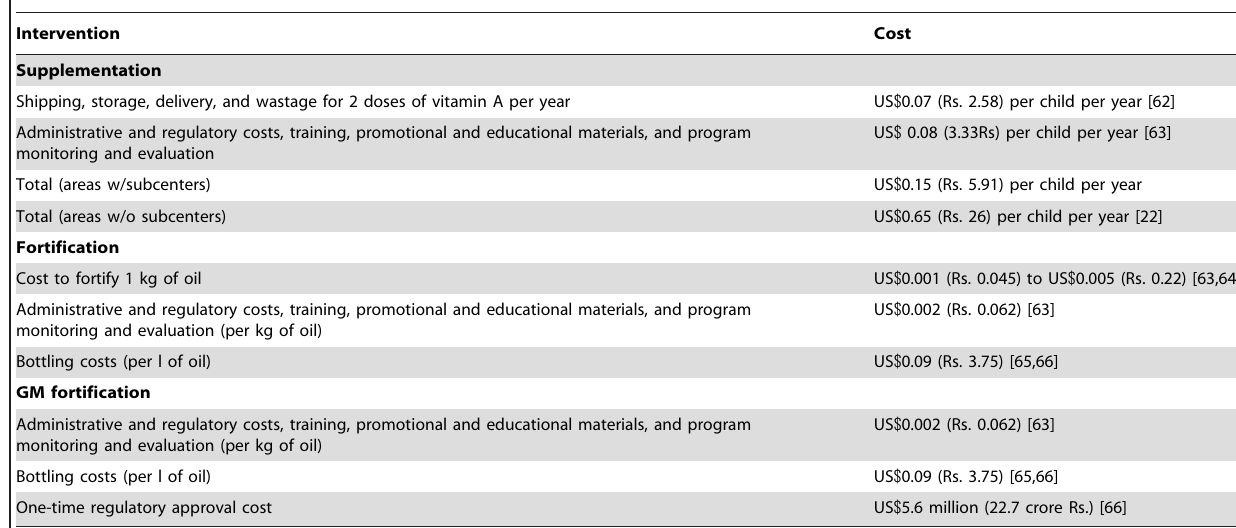
Table 2. Cost of each intervention.